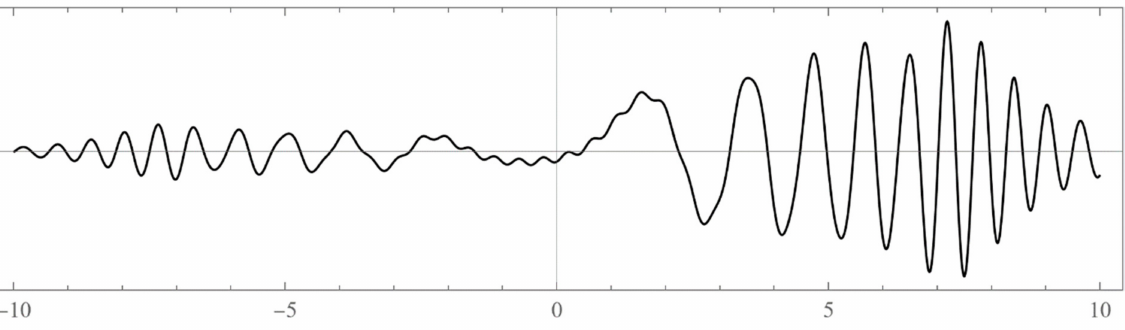
Figure A9. The un-normalized wavefunction (cid:101) ψ ( x , E ) for E = 3 λ 2 /2 in the right energy band. We took N = 100.